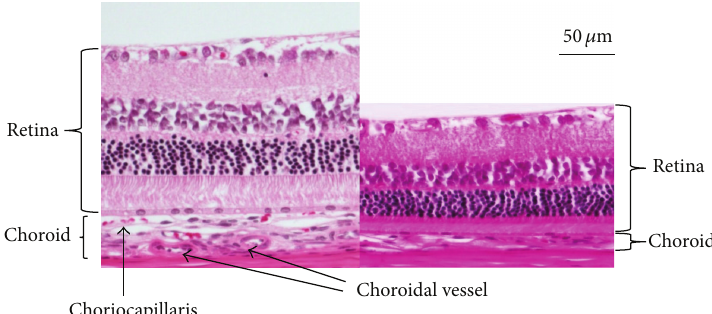
Figure 8: Comparison of the retina and the choroid in a SDT rat (left) and a normal SD rat (right) 1,400 𝜇 m to 1,600 𝜇 m from the optic nerve